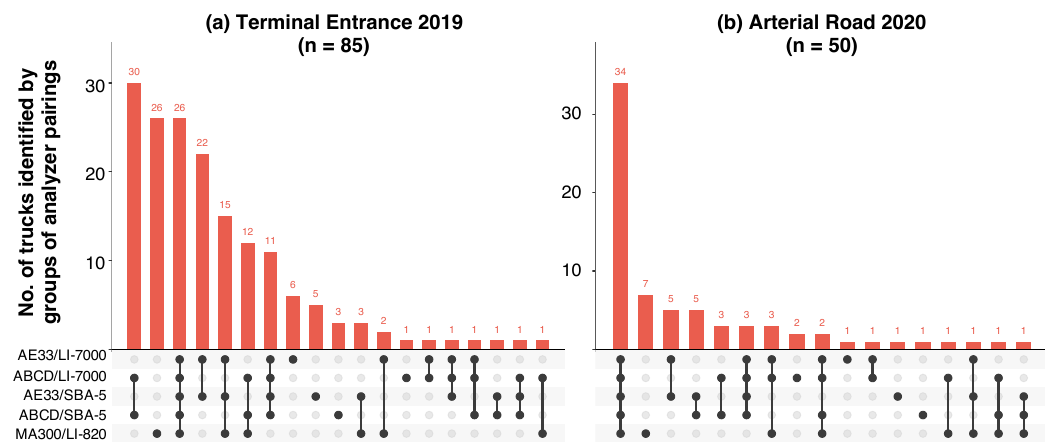
Figure 5. Intersections of high-emitter occurrences across five di ff erent sensor pairs measured at the ( a ) Terminal Entrance and ( b ) Arterial Road. Here, sensor pairs that identify the same high emitters are vertically marked with dots, and the number of occurrences in that intersection is shown as a vertical bar. Each unique intersection is plotted on the horizontal axis, from highest number of occurrences to